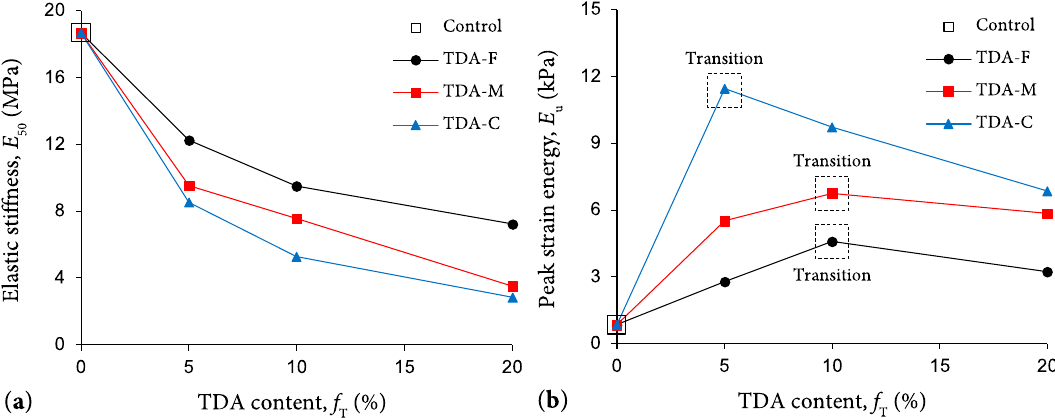
Figure 9. Variations of ( a ) elastic stiffness E 50 and ( b ) peak strain energy E u against TDA content f T for the tested mix designs.